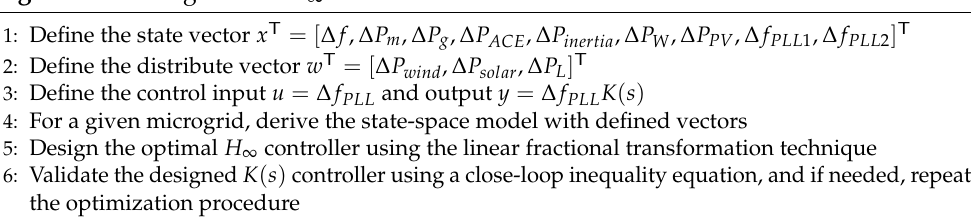
Algorithm 1 Design of the H ∞ controller